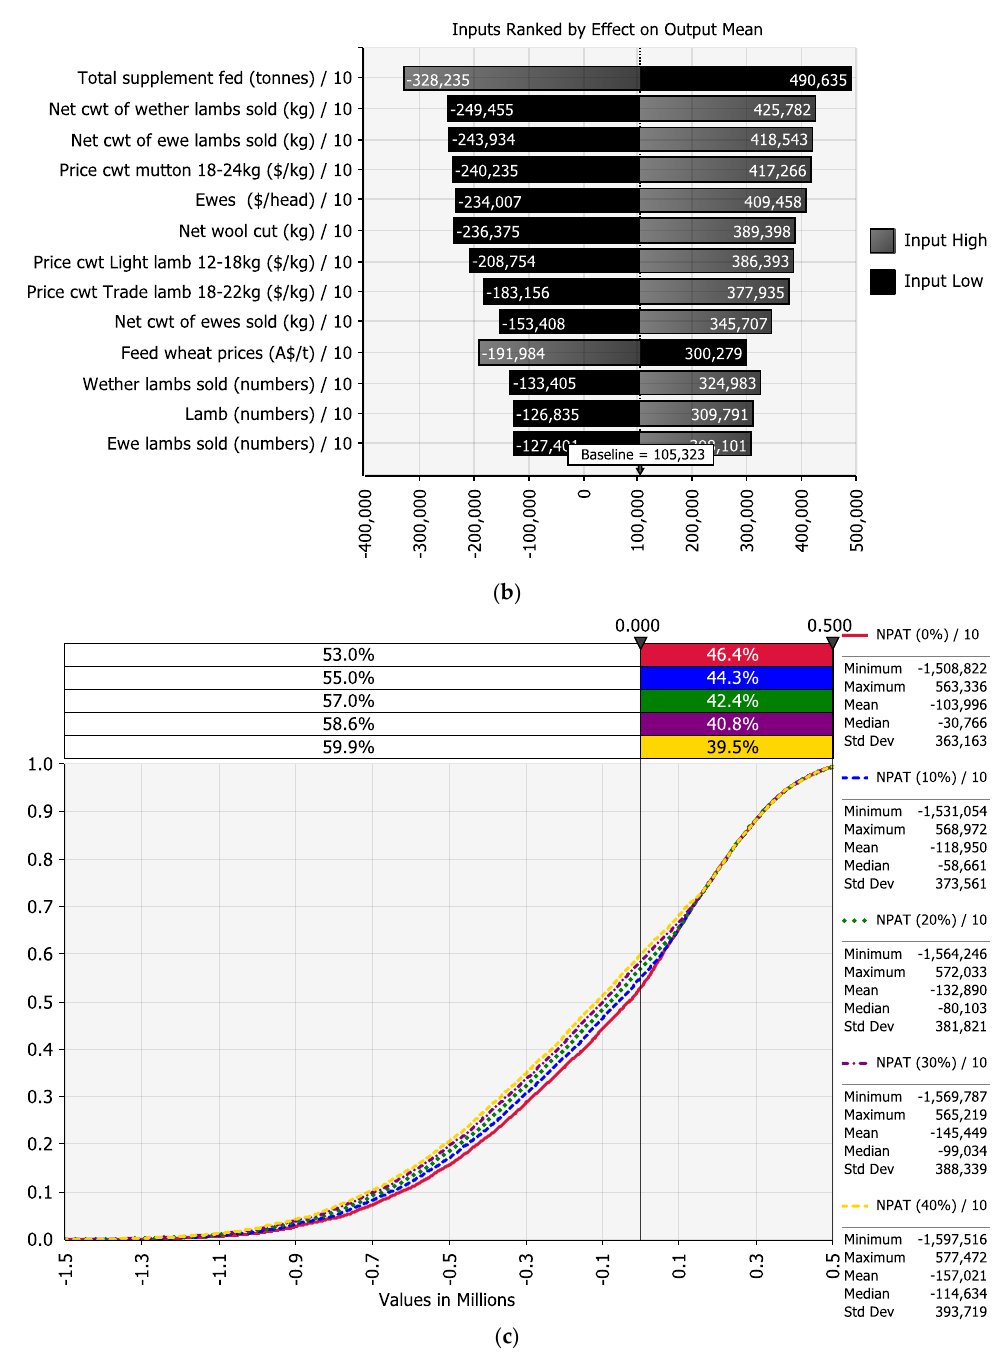
Figure 4. ( a ) Cumulative distribution frequency of total farm gross margin (TGM) in year 10, where the y-axis shows the probability of obtaining a value less than or equal to the corresponding x-axis value. The percentage on the top-right of the graph indicates the proportion of simulated TGM being greater than zero. The percentage on the top-left of the graph indicates the proportion of simulated TGM being less than or equal to zero. ( b ) Mean total gross margin (TGM) values at the highest 10% (dark bars) and lowest 10% (light bars) of simulated values of input variables at year 10. The numbers at the edges of each bar represent the mean TGM values for each selected input. ( c ) Cumulative distribution frequency of Net profit (NP) in year 10 for the five starting debt to equity scenarios, where the y -axis shows the probability of obtaining a value less than or equal to the corresponding x -axis value. The percentage on the top-right of the graph indicates the proportion of simulated TGM being greater than zero. The percentage on the top-left of the graph indicates the proportion of simulated TGM being less than or equal to zero. Summary statistics for each D:E scenario are provided on the right-hand